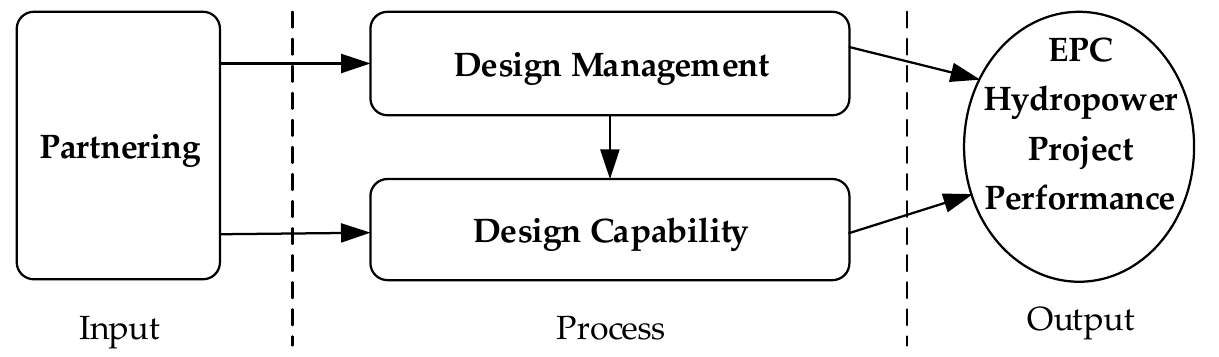
Figure 1. Design management model for delivering EPC hydropower projects.